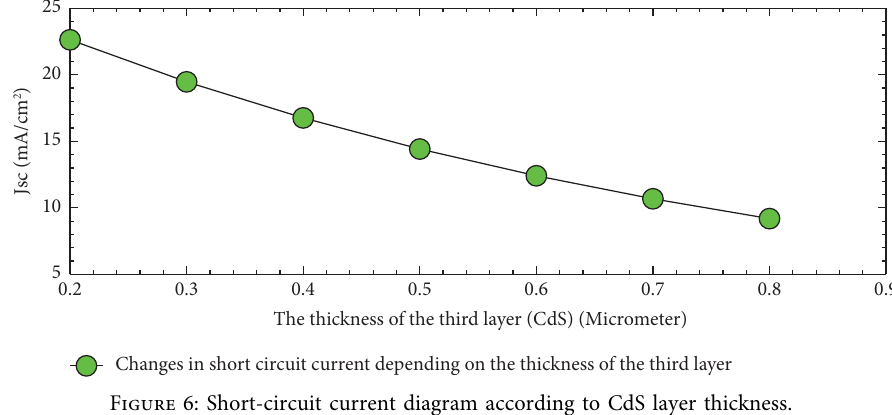
Figure 6: Short-circuit current diagram according to CdS layer thickness.